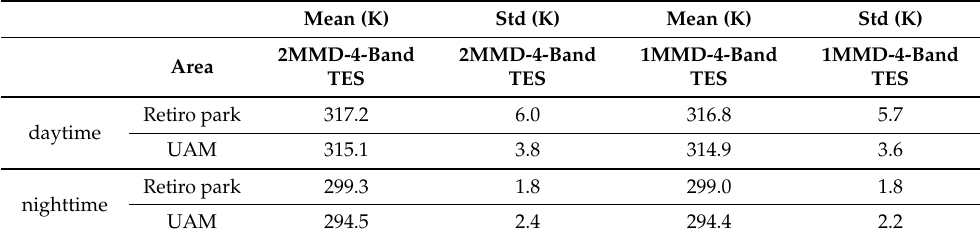
Table 9. First-order statistics for the aggregated LST maps according to each method.